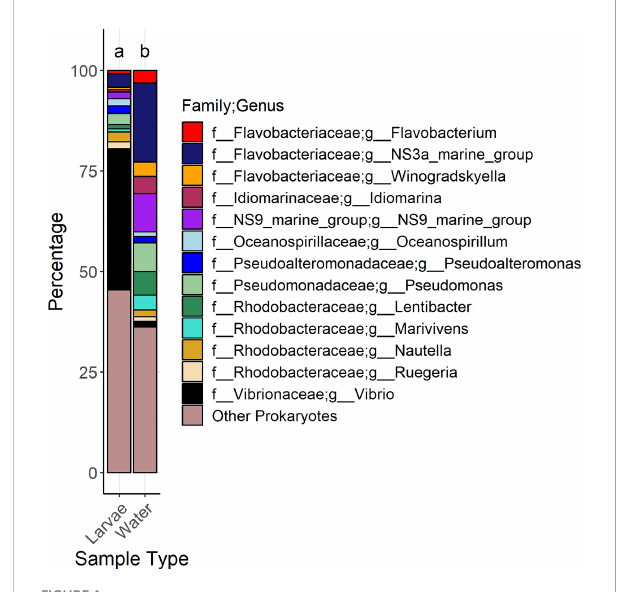
FIGURE 1 Stacked bar graphs showing the genera that had a mean relative abundance greater than 1% across all samples associated with water and larvae samples. Genera and associated families are represented by color. Letters above the bar plots indicate results of permutational analysis of variance testing. Different letters between bar plots means that the sample types were statistically different (Pseudo-F value < 0.05).